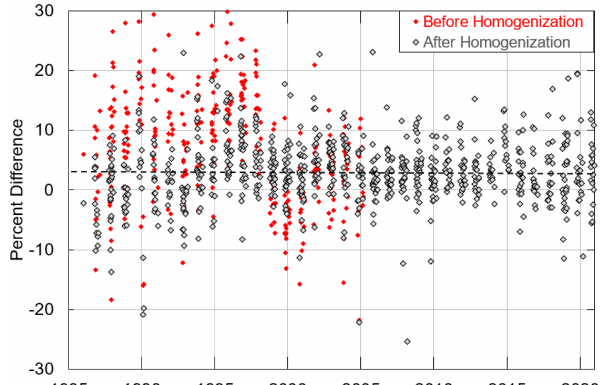
Figure 1. Percent difference (100 × (sonde − Dobson) / Dob- son) comparing total column ozone of the South Pole ozonesondes and Dobson spectrophotometer direct-sun AD wavelength measure- ments. The solid red diamonds represent the percent differences be- fore the homogenization of the 1986–2006 ozonesonde data. The gray diamonds show a more consistent record after homogenization. The dashed horizonal line shows the trend in the offset is relatively stable at